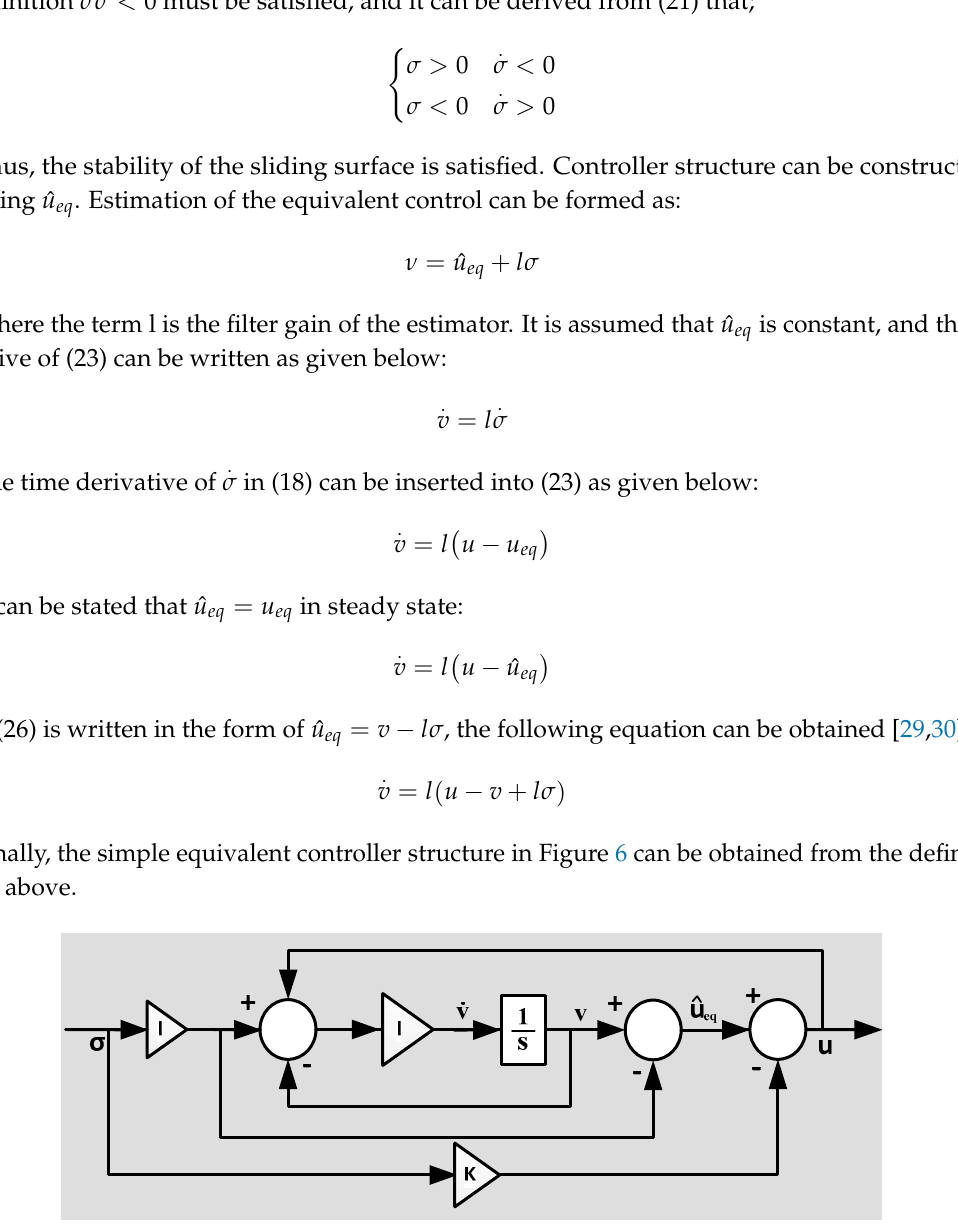
Figure 7. Dynamic relay with hysteresis function.